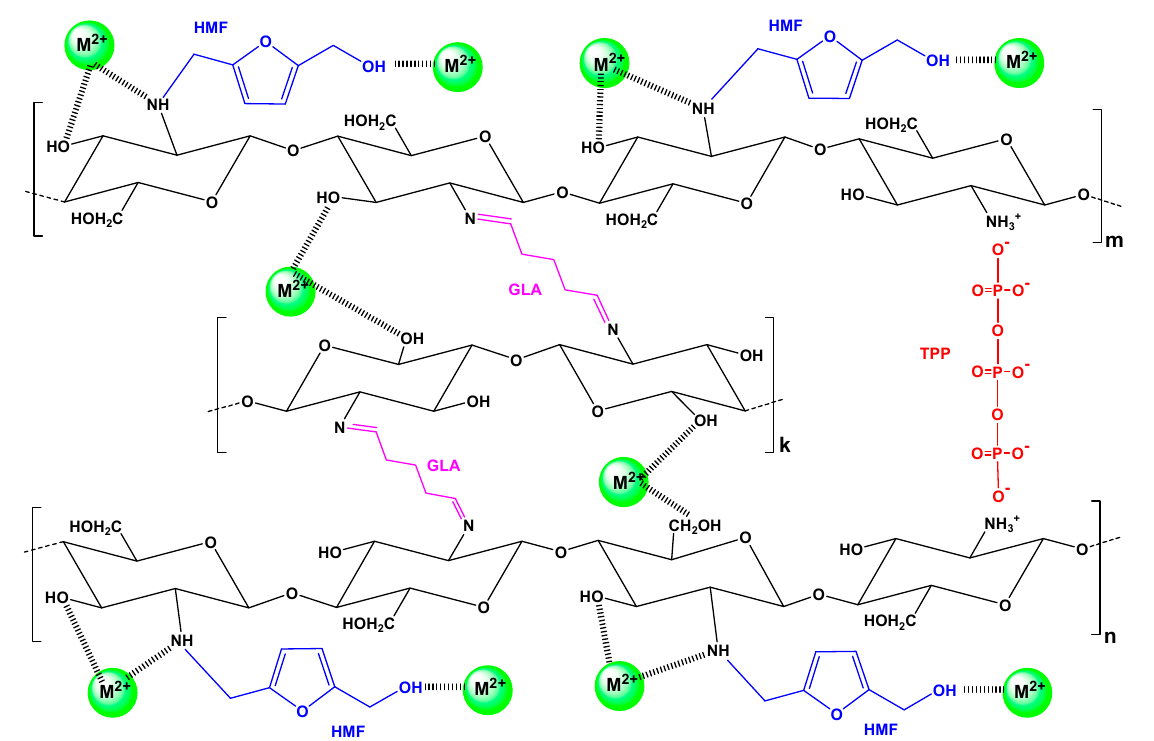
Figure 3. Proposed interactions for the removal of metal ions M 2+ (Ni 2+ , Hg 2+ , Ba 2+ ) by adsorption onto CS-HMF.